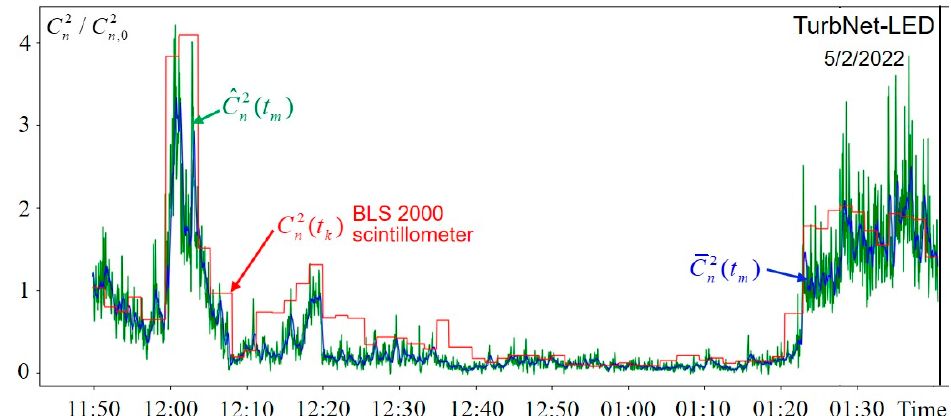
Figure 9. “Measurement-vs.-prediction” dataplots (see Figure 8 caption) obtained during the atmospheric inference trial with the TurbNet-LED sensor performed six months after collection of the dataset used for DNN model training.